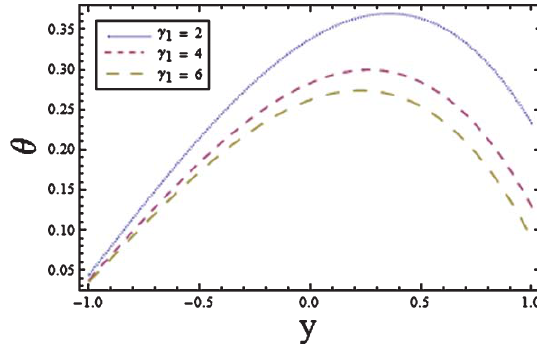
Fig. 7. Plot of the temperature θ for various values of the Biot number γ